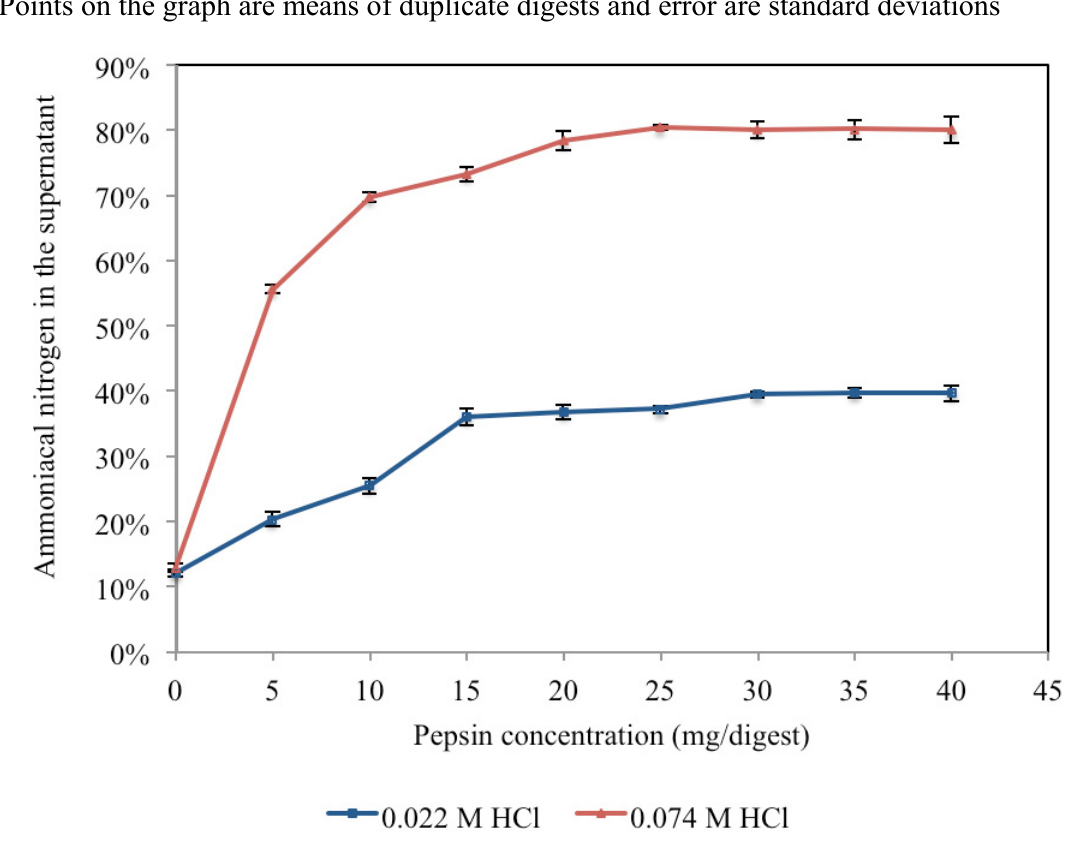
Figure 3. Effect of pepsin concentration on protein hydrolysis of 600 mg freeze-dried meat at two acid concentrations (0.022 M and 0.074 M HCl) measured by percentage of ammoniacal nitrogen in the supernatant of the hydrolysate after 60 min incubation at 37 °C. Points on the graph are means of duplicate digests and error are standard